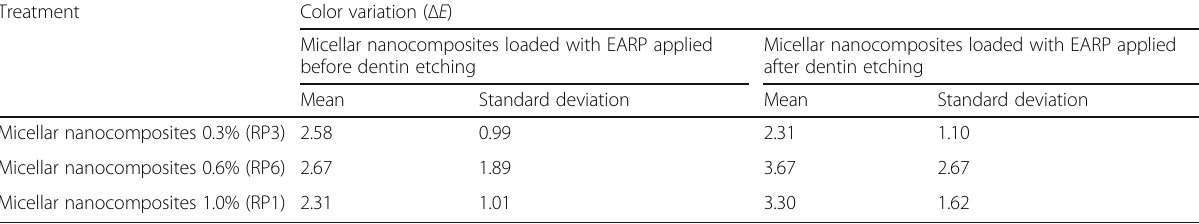
Table 3 Mean values of total color variation ( Δ E ) according to treatment and processing technique Treatment Color variation ( Δ E ) Micellar nanocomposites loaded with EARP applied before dentin etching